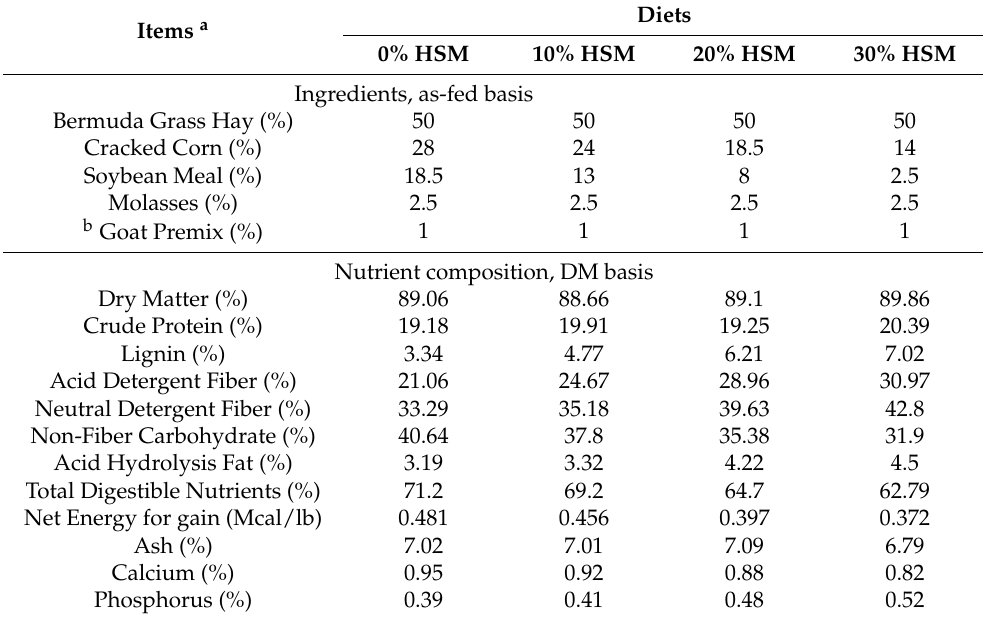
Table 2. Ingredients and nutrient composition of the experimental diets fed to Boer crossbred meat